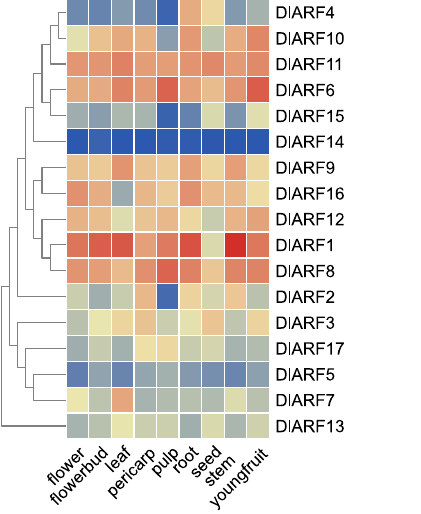
Figure 5. Expression analysis of DlARF genes in different tissues of longan.